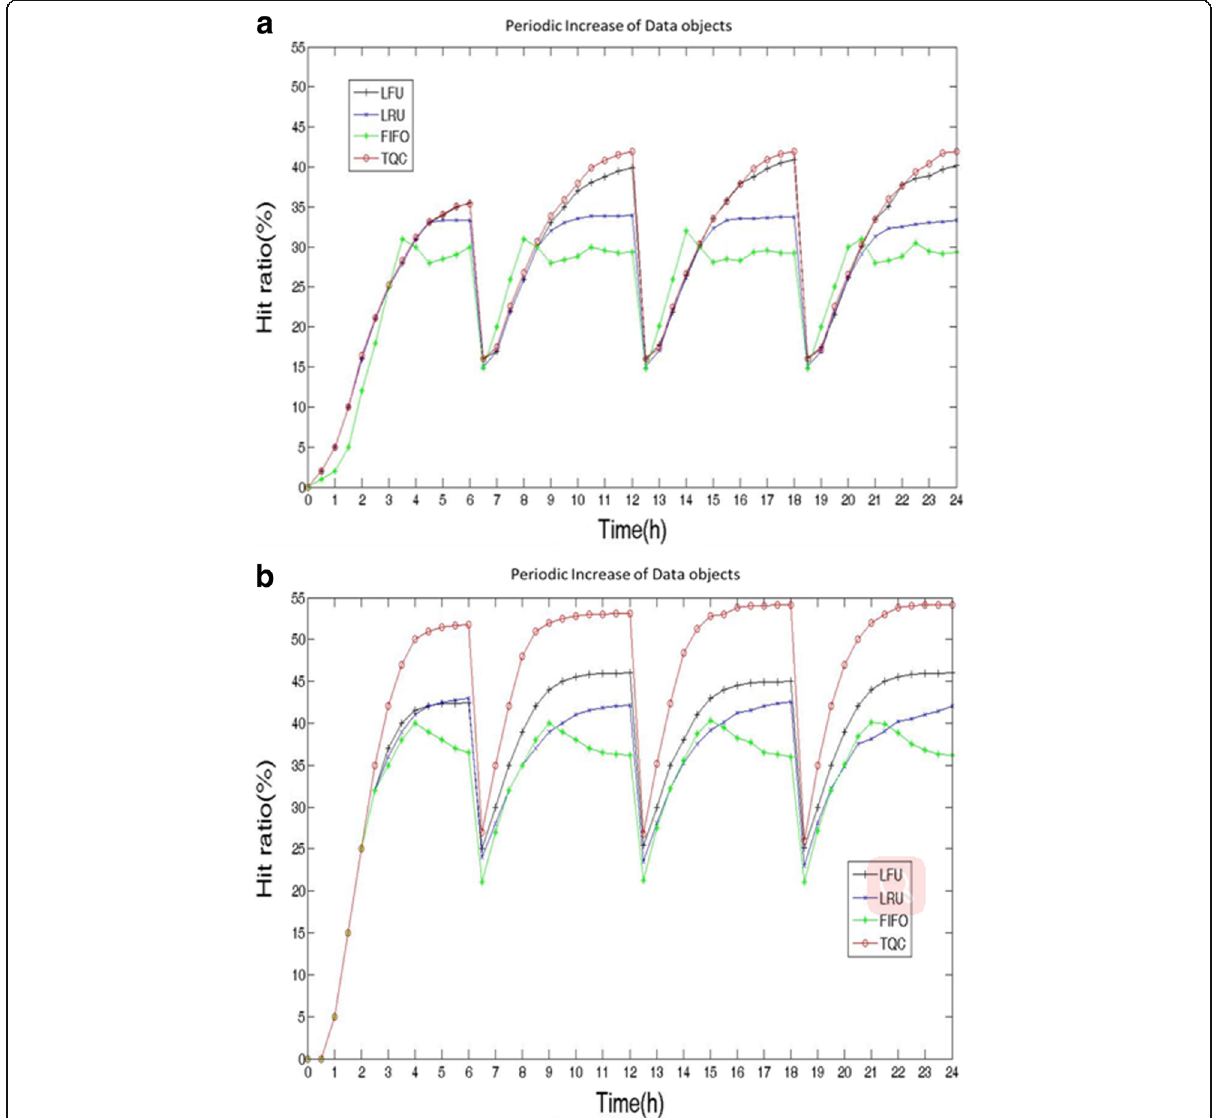
Fig. 5 Periodic increase of data objects. a The changes of hit ratio at cache capacity C =64GB and C =32GB. 3a shows that when the cache capacity is 32 GB, at t =6, 12, and 18 h, each time new data is generated, LFU robustness is the best and TQC efficiency will decline, because TQC needs some time to learn new files. b indicates that TQC outperforms LFU over a long period of time when the cache increases to 64 GB. This is mainly because LFU accumulates a large number of access requests for a long time which requires more time to judge new data and replace old data. Based on the learning mode of time series, with very little storage space and computing resources, TQC can learn low-frequency and long-period request patterns so as